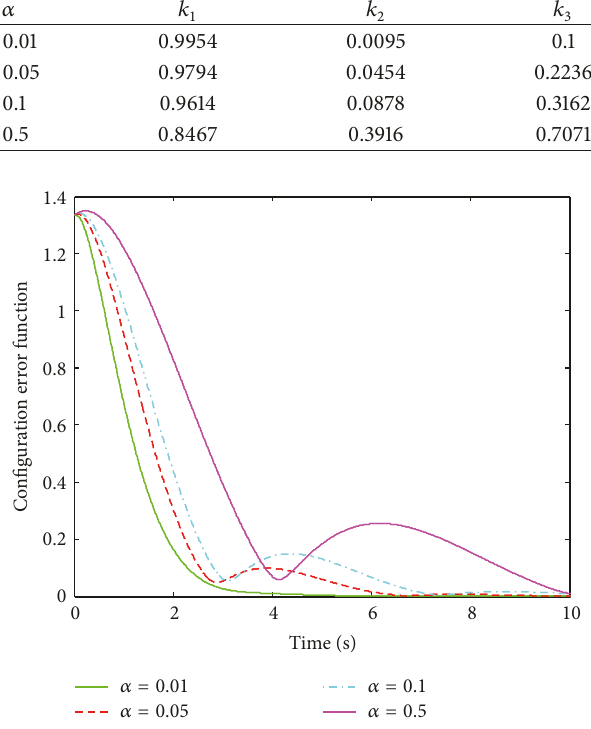
Figure 1: Configuration error function values with different